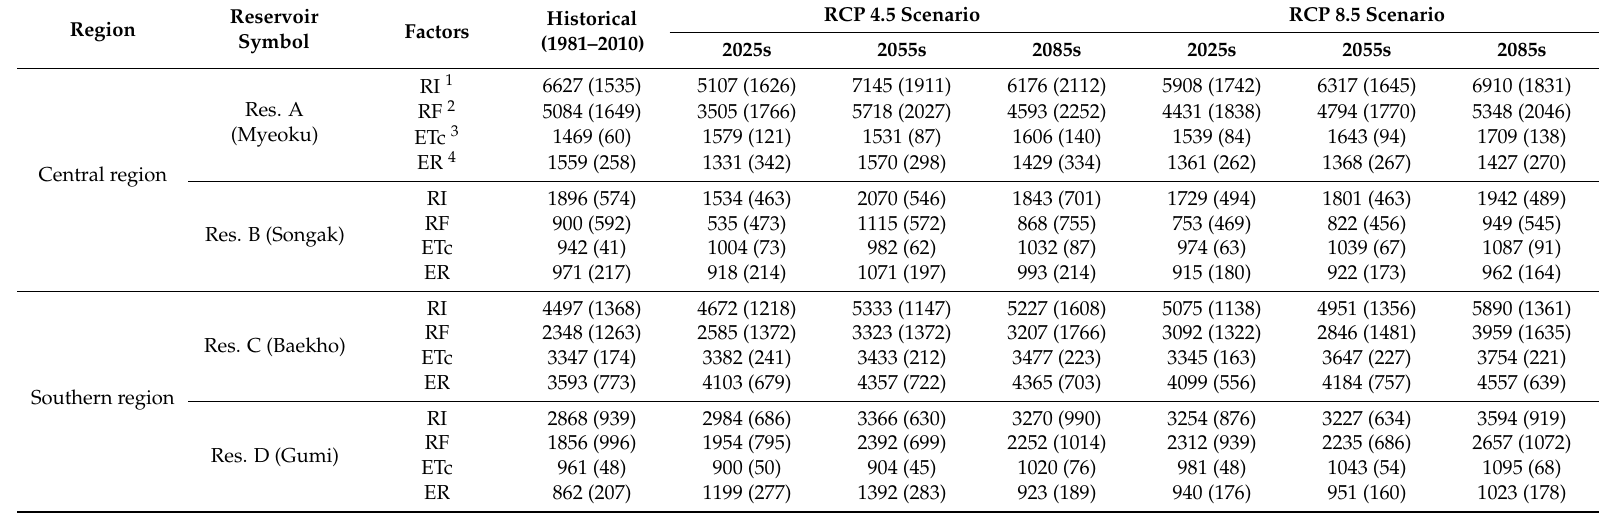
Table 6. Comparisons of RI, RF, ETc and ER between the historical period and climate change period.